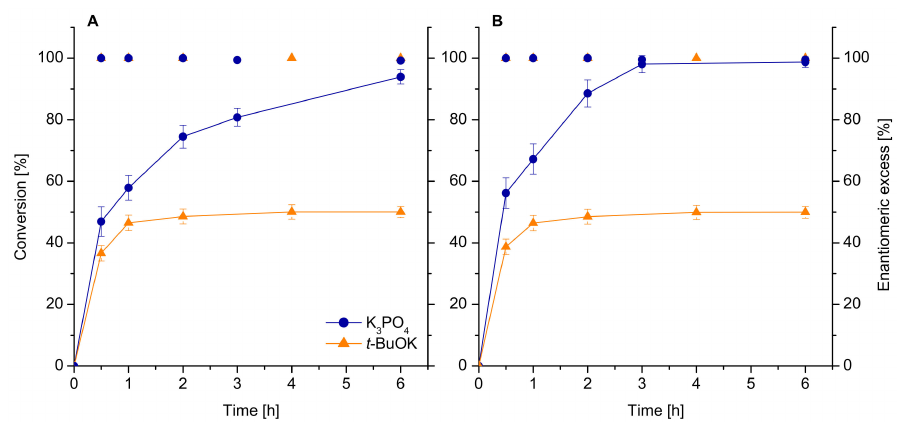
Figure 4. Conversion and enantiomeric excess of the ( R )-1-phenylethyl acetate vs. time in the dynamic kinetic resolution of ( rac )-1-phenylethanol catalyzed by Novozym 435 and ruthenium complexes: 1 ( A ) and 2 ( B ), using two activators (K 3 PO 4 and t